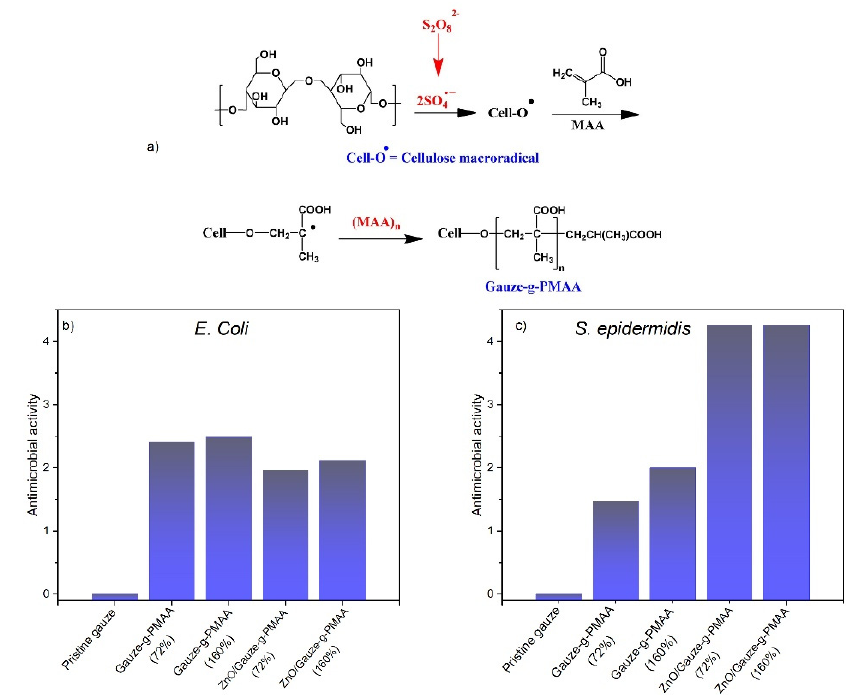
Figure 6. ( a ) Reaction scheme for modification of cotton gauzes with PMAA by free radical polymer- ization. ( b , c ) Antimicrobial activity for pristine and modified cotton gauzes against E. coli ( b ) and S. epidermidis bacteria ( c ). Reprinted with permission from Ref. [81]. Copyright 2019 Elsevier.